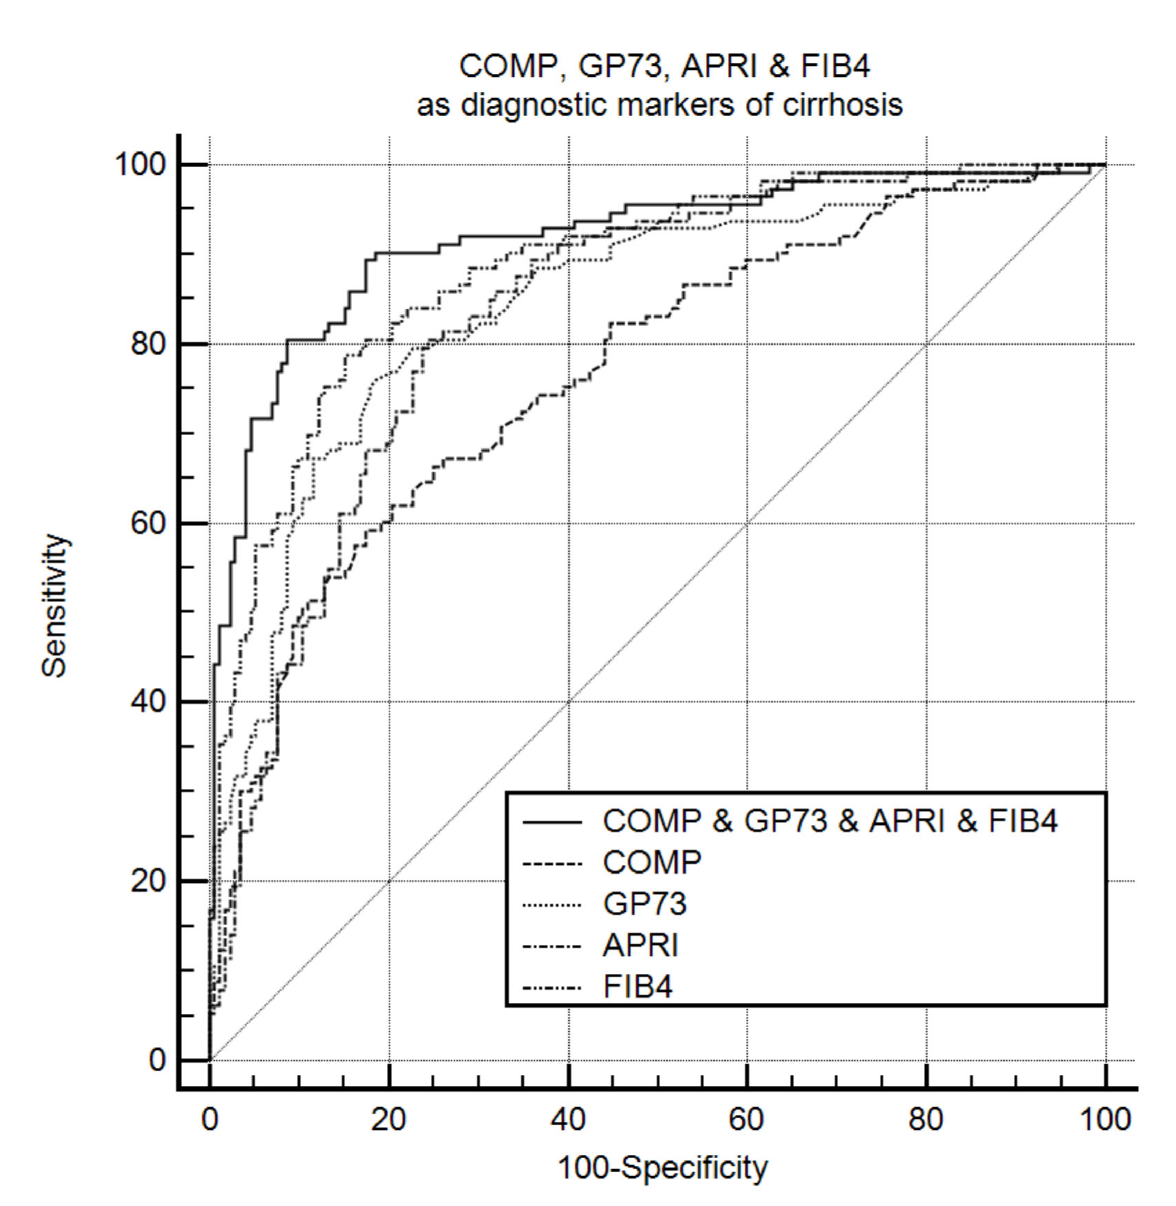
Figure 2. COMP, GP73, APRI, and FIB-4 as diagnostic markers of cirrhosis ( n = 288). Receiver operating characteristic curves for the prediction of cirrhosis according to COMP, GP73, APRI, and FIB-4. The combination of COMP, GP73, APRI, and FIB-4 had the highest diagnostic accuracy for cirrhosis [AUC (95% CI): 0.916 (0.878–0.946)] than each marker alone: GP73 [AUC (95% CI): 0.843 (0.795–0.883); P < 0.001], COMP [AUC (95% CI): 0.770 (0.716–0.817); P < 0.001], APRI [AUC (95% CI): 0.833 (0.784–0.874); P < 0.001], and FIB-4 [AUC (95% CI): 0.885 (0.846–0.920); P = 0.02]. COMP: Cartilage oligomeric matrix protein. GP73: Golgi protein 73. APRI: Aspartate aminotransferase to platelets index. FIB-4: Fibrosis-4. AUC: Area under the